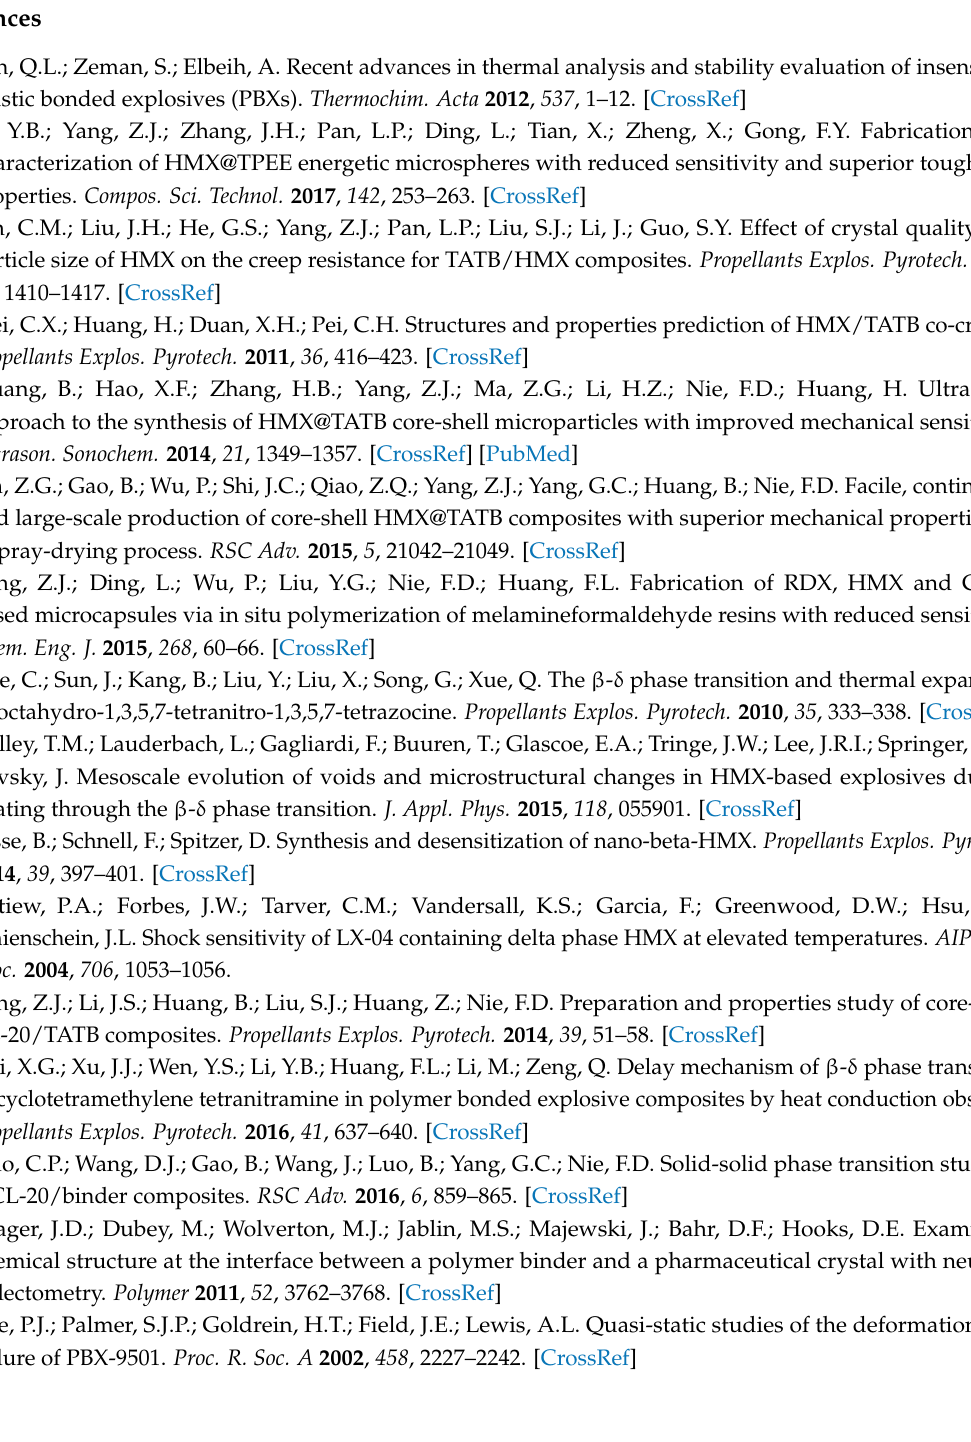
Table S5: Thermal analysis data of the PDA modified PBXs, Table S6: Thermal analysis data of HMX crystals